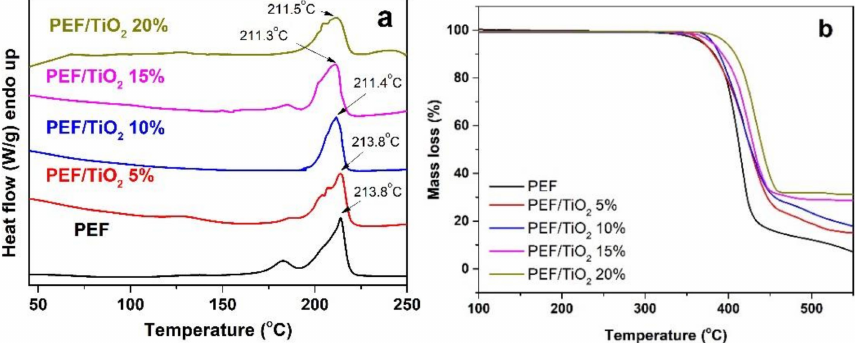
Figure 4. ( a ) DSC thermograms and ( b ) TGA thermograms of PEF and its nanocomposites with TiO 2